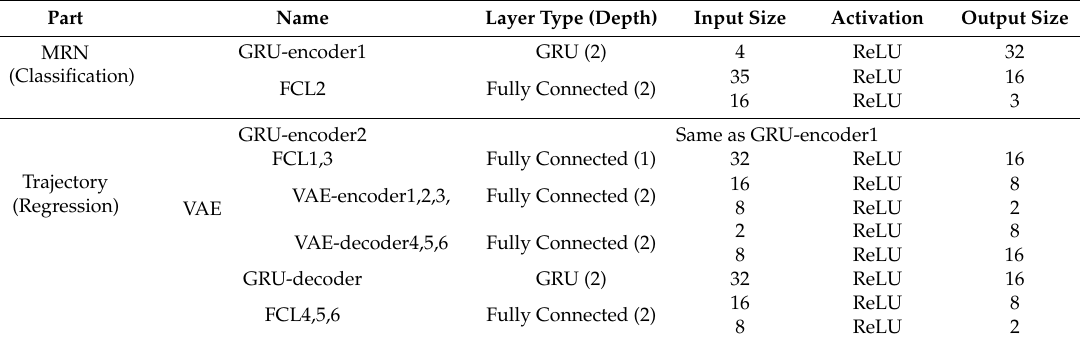
Table 1. Details of the Road-Aware Trajectory Prediction